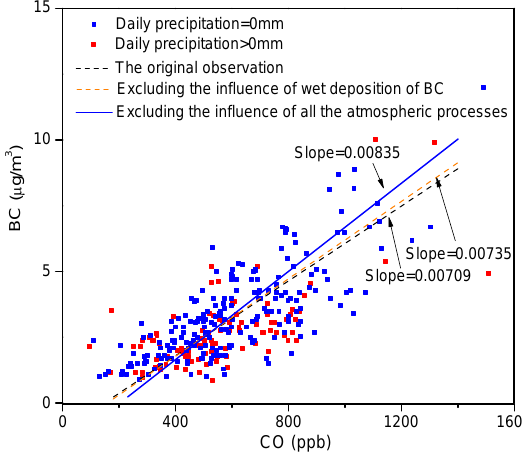
Figure 8. The correlation of daily BC and CO concentrations at Caochangmen site and the emission ratios of BC to CO from bottom-up inventories for Nanjing,